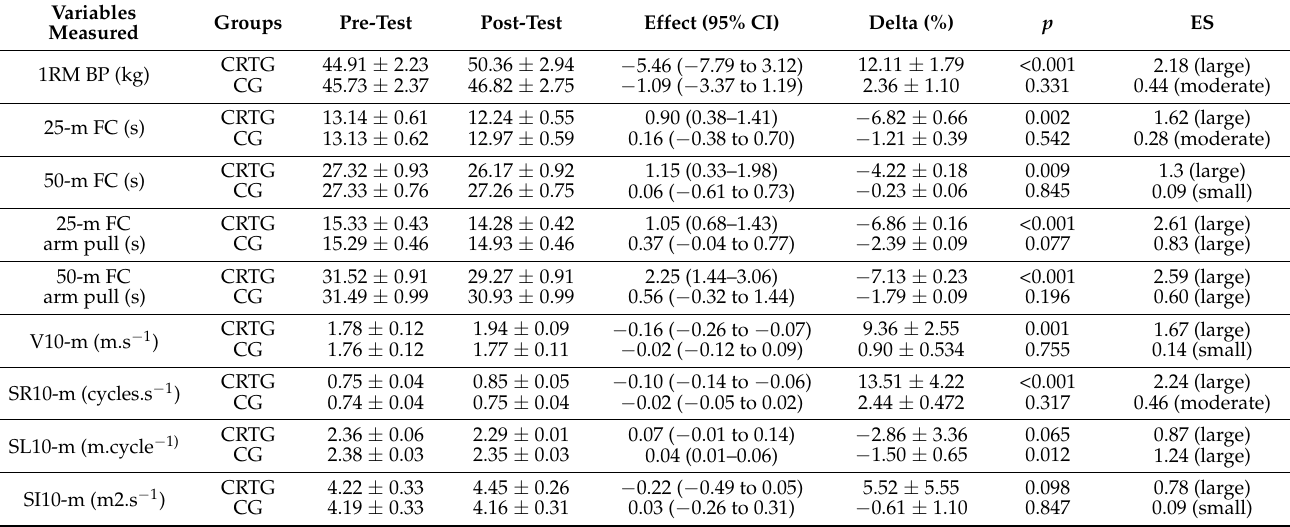
Table 4. Changes in the maximum upper body strength, sprint swimming performance and kinematic variables between the pre- and